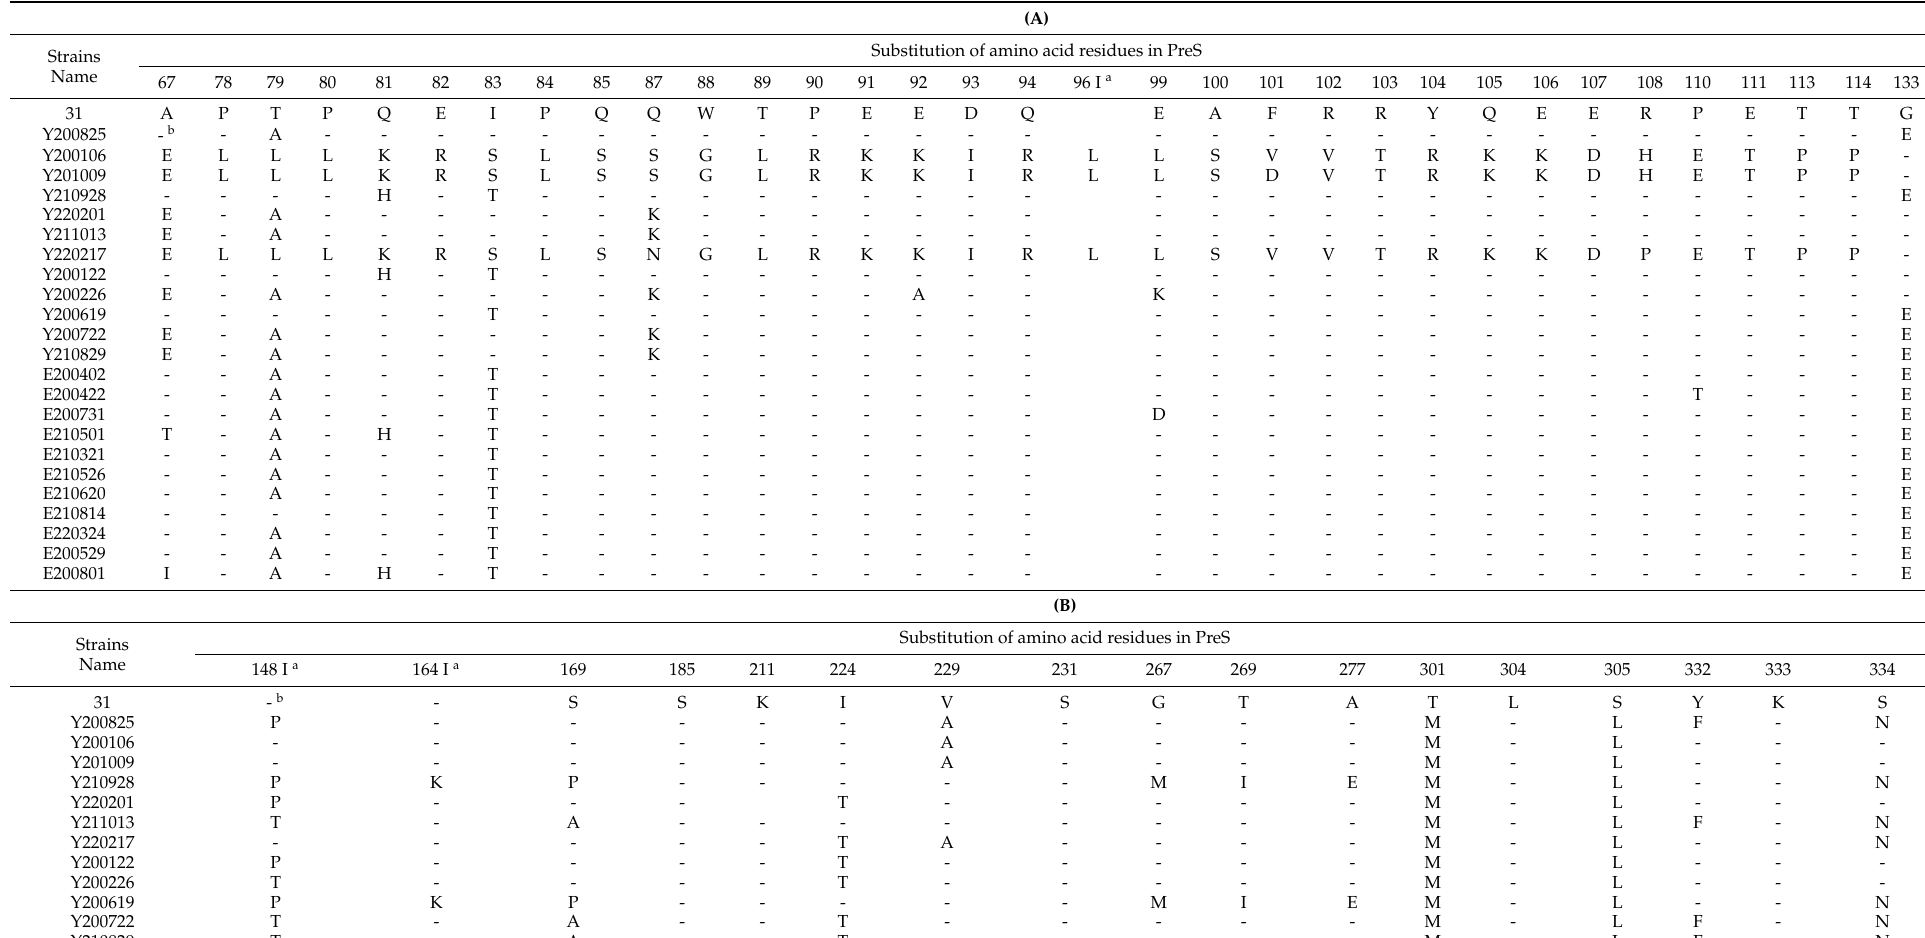
Table 1. (A). Mutation sites of PreS compared with the amino acid residues of the DHBV reference strains (31, GenBank accession number: AY250901, 67–133 aa). (B). Mutation sites of PreS compared with the amino acid residues of the DHBV reference strains (31, GenBank accession number: AY250901,148–334 aa).